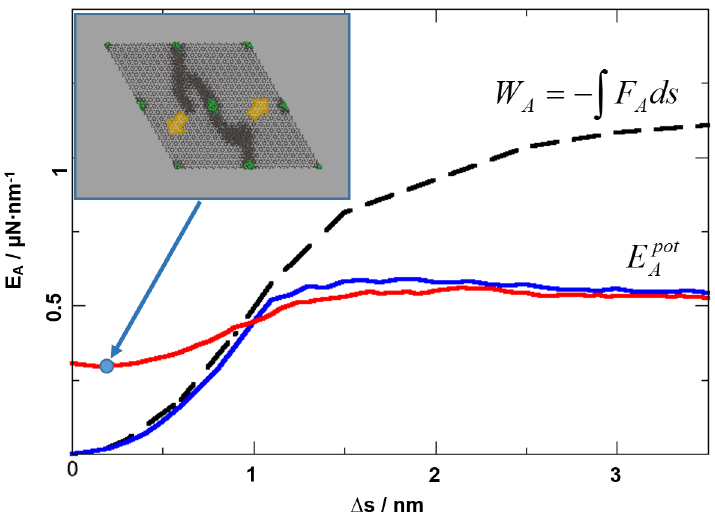
Fig 2. Potential energy (blue curve) and mechanical work (black curve) per nm 2 as functions of model stretching Δ s along the (100) direction. Upon elongation by about 1 nm, the deformation mechanism changes from elastic to plastic. After stretching up to the fracture limit of 3.5 nm, relaxation is investigated by reversing the strain rate. The inset at the top left shows that the system does not immediately recover to the pristine configuration, but retains considerable plastic deformation. As a consequence, the corresponding potential energy profile (red curve) exhibits an offset in both energy and equilibrium geometry. Note that despite the limited dimensions of the atomistic model, the onset of fracture bifurcation (highlighted by yellow arrows) is — at least qualitatively — already observed.